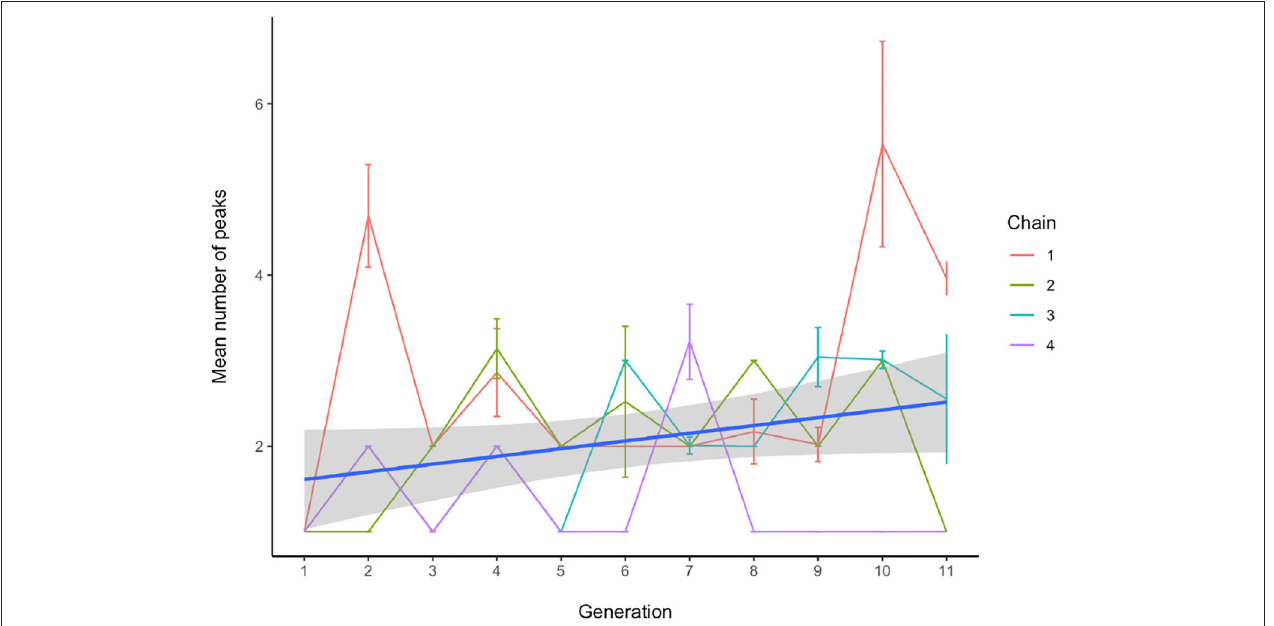
FIGURE 7 | The number of whistle tone clusters found by the Gaussian Mixture models. Earlier productions tend to exhibit more continuous use of the pitch space, while in later generations, more distinct clusters are found. Even though results vary per chain, overall a significant increase in the number of discrete tone categories is